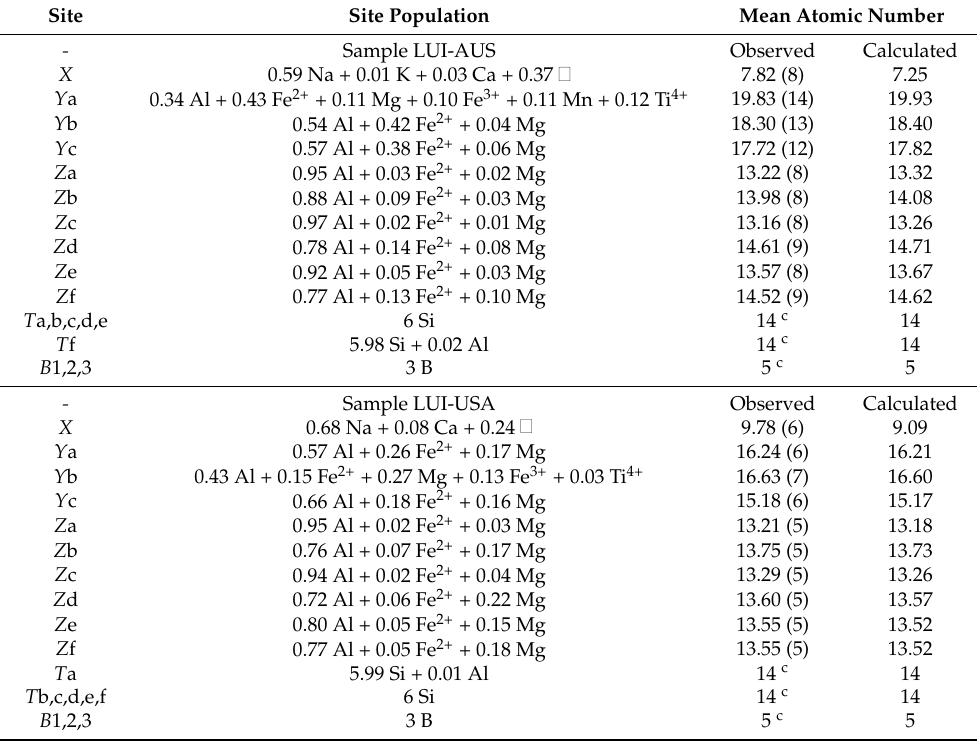
Table 4. Optimized cation site populations a (in atoms per formula unit) and mean atomic number b for luinaite -( OH